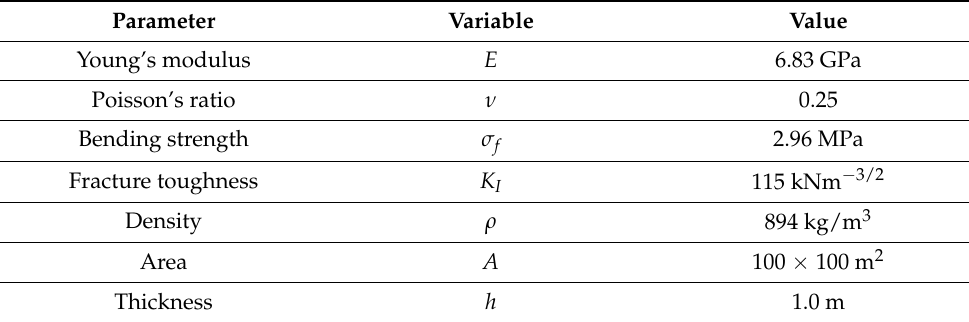
Table 3. Parameters of level